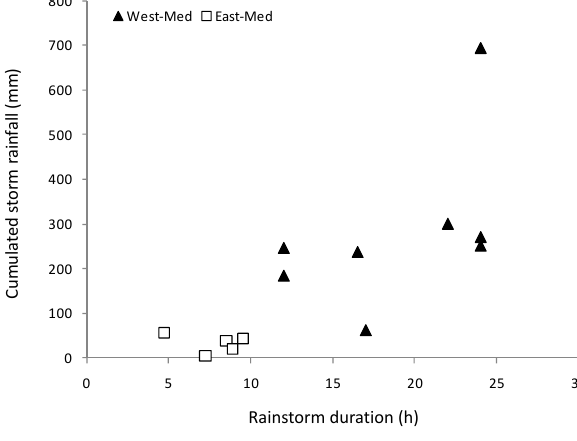
Fig. 5. Rainstorm characteristics: rainstorm duration versus cumu- lated event